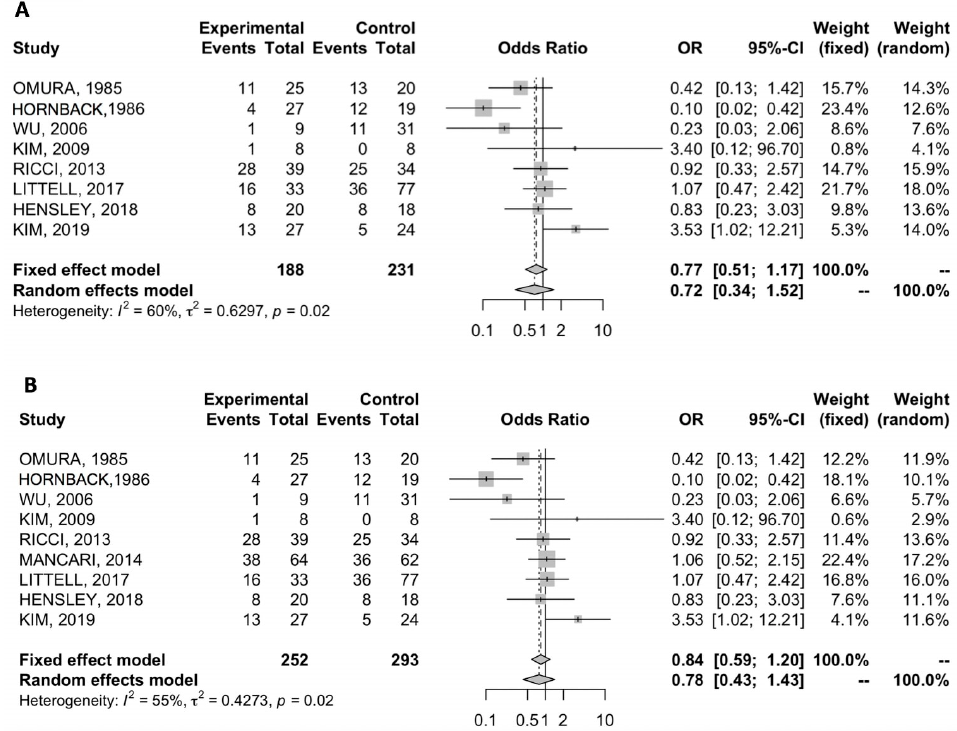
Figure 3. ( A ) Forest plot of comparison between adjuvant chemotherapy versus observation; the outcome was OR of overall recurrence rate; ( B ) forest plot of comparison between adjuvant chemotherapy versus observation (cid:31) radiation therapy; the outcome was odds ratio of overall recurrence rate.